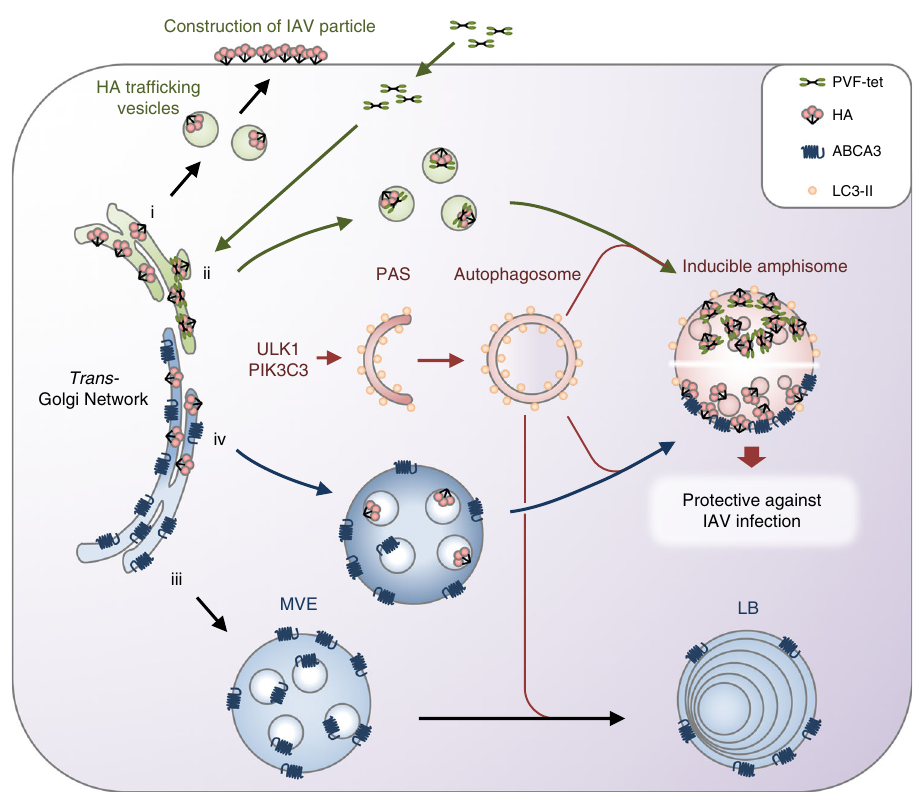
Fig. 8 Mechanism of formation of the inducible amphisome with anti-IAV activity. After IAV infection, newly synthesized HA is transported to the apical surface of the plasma membrane via vesicular traf fi cking (i). PVF-tet can penetrate into the cells and directly bind to the newly synthesized HA in the trans - Golgi Network to form an HA-containing structure. This structure subsequently matures into the amphisome, resulting in the sequestration of HA in this structure to inhibit virus propagation. Autophagic machinery is essential for this maturation step, because gene knockout of PIK3C3 and ULK1, both of which are indispensable for the formation of an autophagosome from a pre-autophagosomal structure, abrogates the sequestration (ii). In general, ABCA3 has an essential role in the maturation of the multivesicular endosome into the lamellar body through fusion with the autophagosome (iii). After IAV infection, even in the absence of PVF-tet, the overproduction of lamellar bodies promoted by overexpression of ABCA3 can induce the formation of amphisomes with anti-IAV activity depending on the autophagic machinery